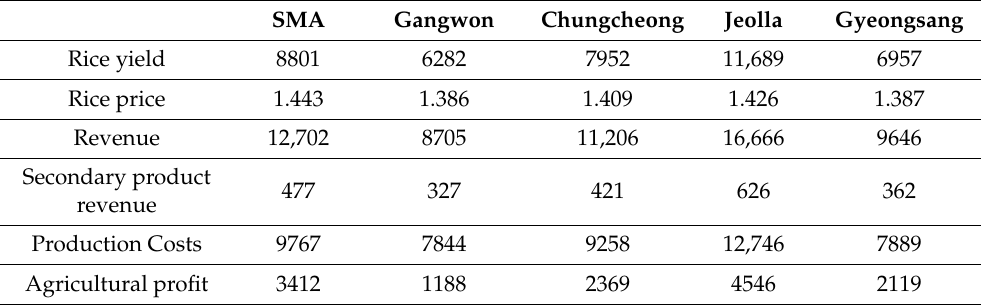
Table 8. Agricultural profit without APV installation